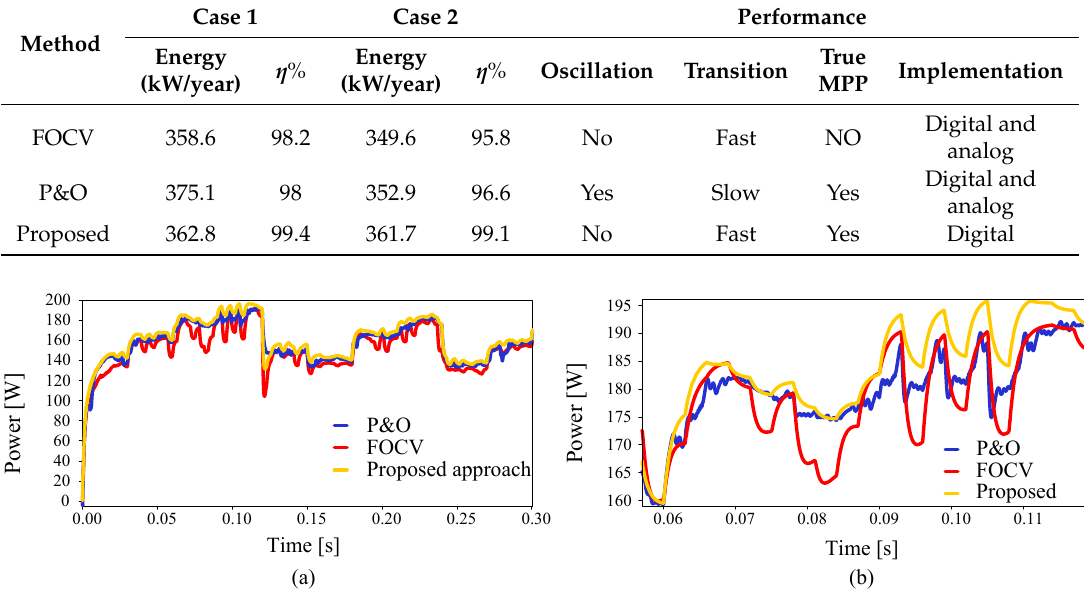
Table 2. Performance comparison of the proposed method with commonly used methods.